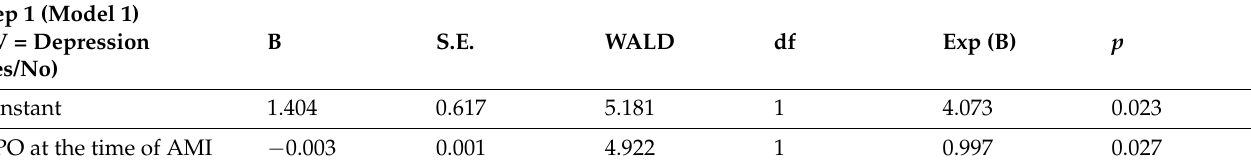
Table 2. Two-step hierarchical logistic regression models of AMI-induced